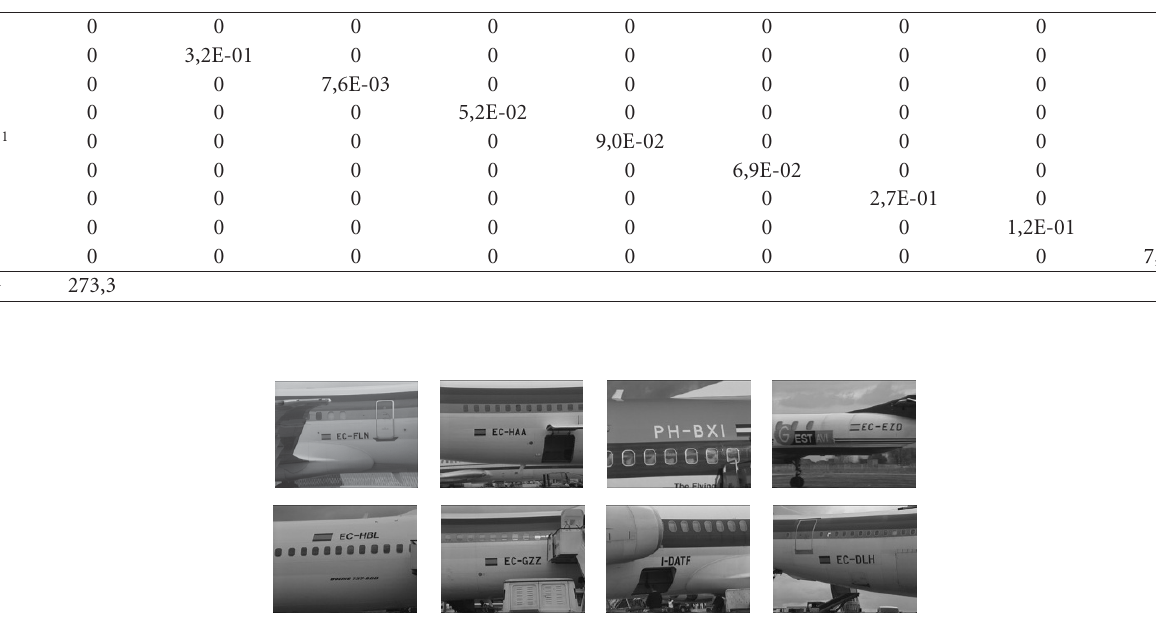
Table 3: Distance matrix Σ − 1 and α H averaged in 100 runs of ( µ + λ )-ES. Values below 1E-3 are set to zero.